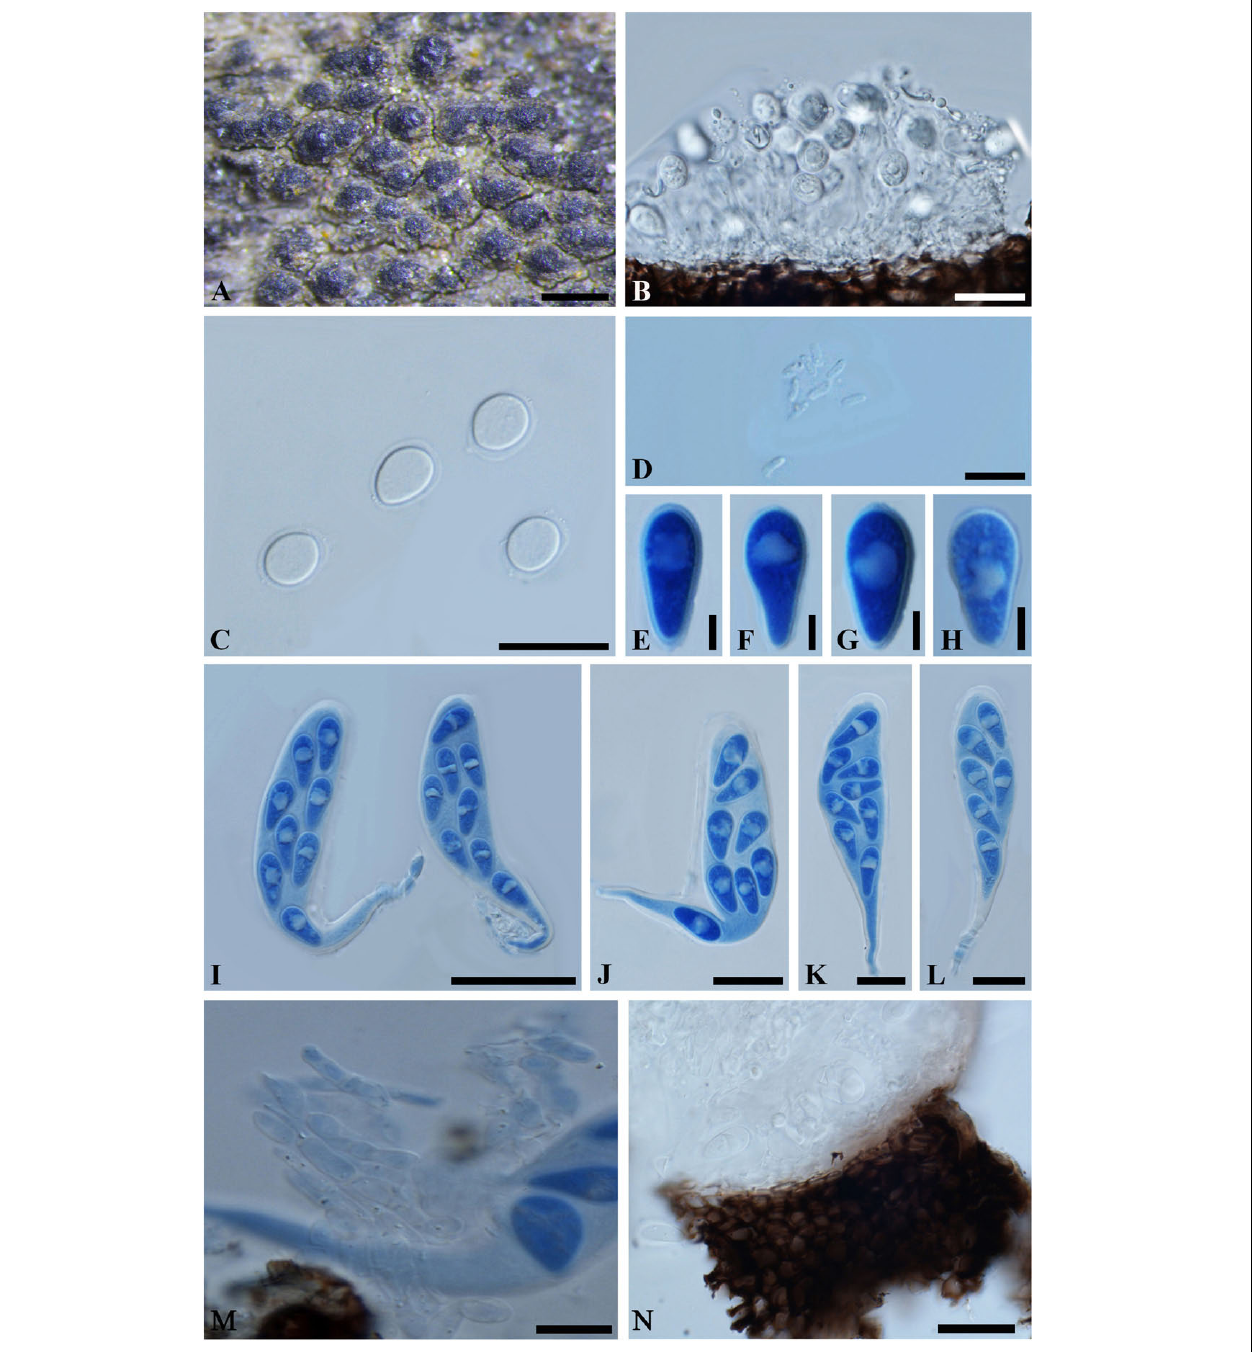
FIGURE 4 | Neodeightonia mucosa (IMI 204341, type ). (A) Aggregated ascomata erumpent through the twig. (B) Longitudinal section of a conidioma. (C) Conidia surrounded by a thin gelatinous sheath. (D) Spermatia. (E-H) Ascospores in cotton blue. Note the distinct oil drop in the ascospores. (I–L) Broadly clavate asci with a long, narrowed, and twisted pedicel in cotton blue. (M) Fragments of cellular pseudoparaphyses. (N) Part of peridium. Scale bars: (A) = 500 µ m, (B,C,J-L) = 20 µ m, (D,M,N) = 10 µ m, (E-H) = 5 µ m, (I) = 50 µ m.